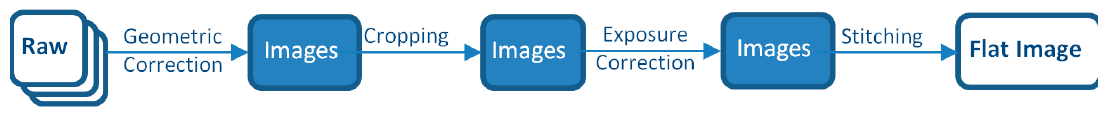
Figure 6. System operation steps.